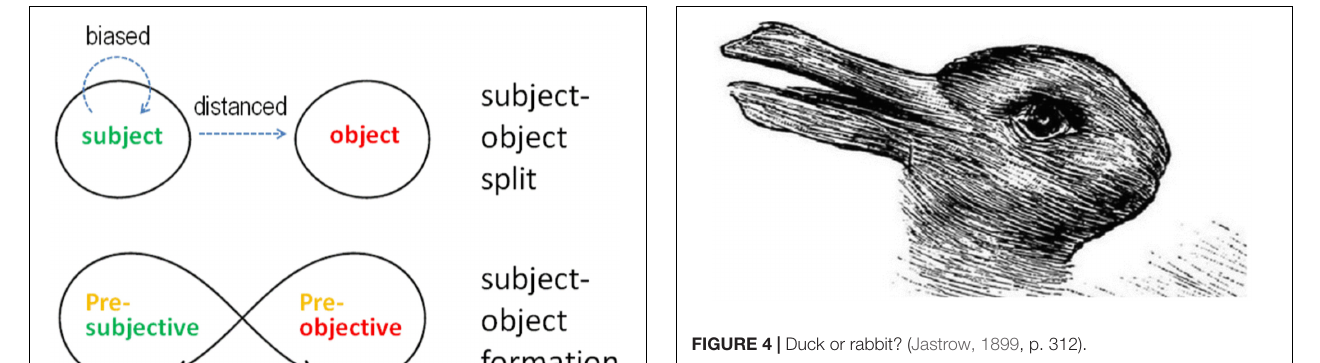
FIGURE 4 | Duck or rabbit? (Jastrow, 1899, p.